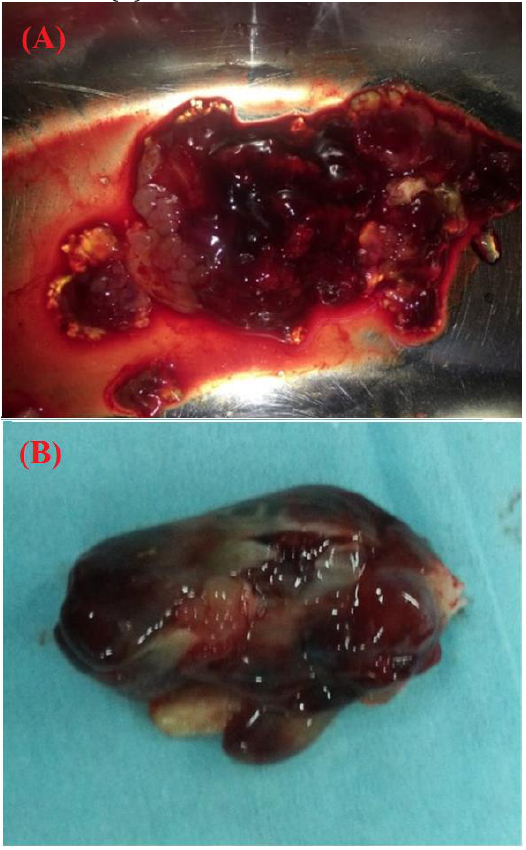
Figure 4: Specimin of excised atrial myxoma. in (12) SMS, and (11)